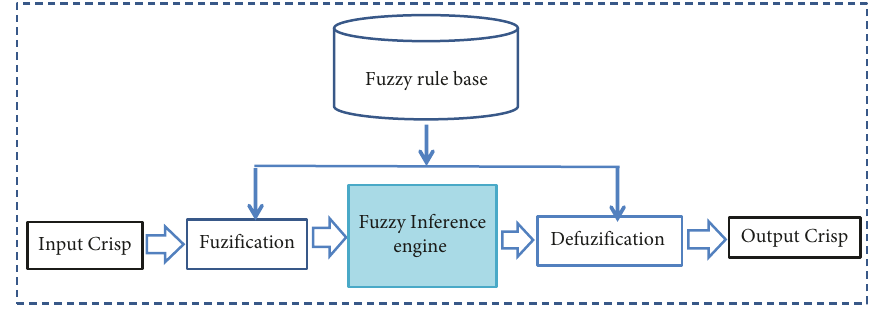
Figure 1: Architecture of the fuzzy logic system. Table 1: Input factor with its linguistic